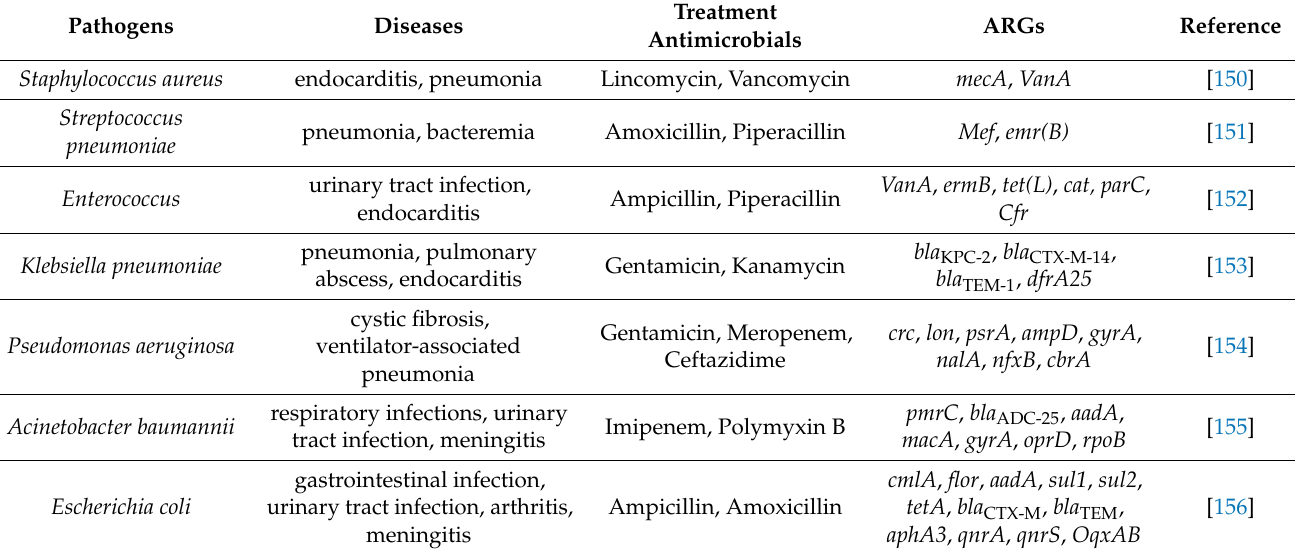
Table 2. ARGs carried on common pathogens and related